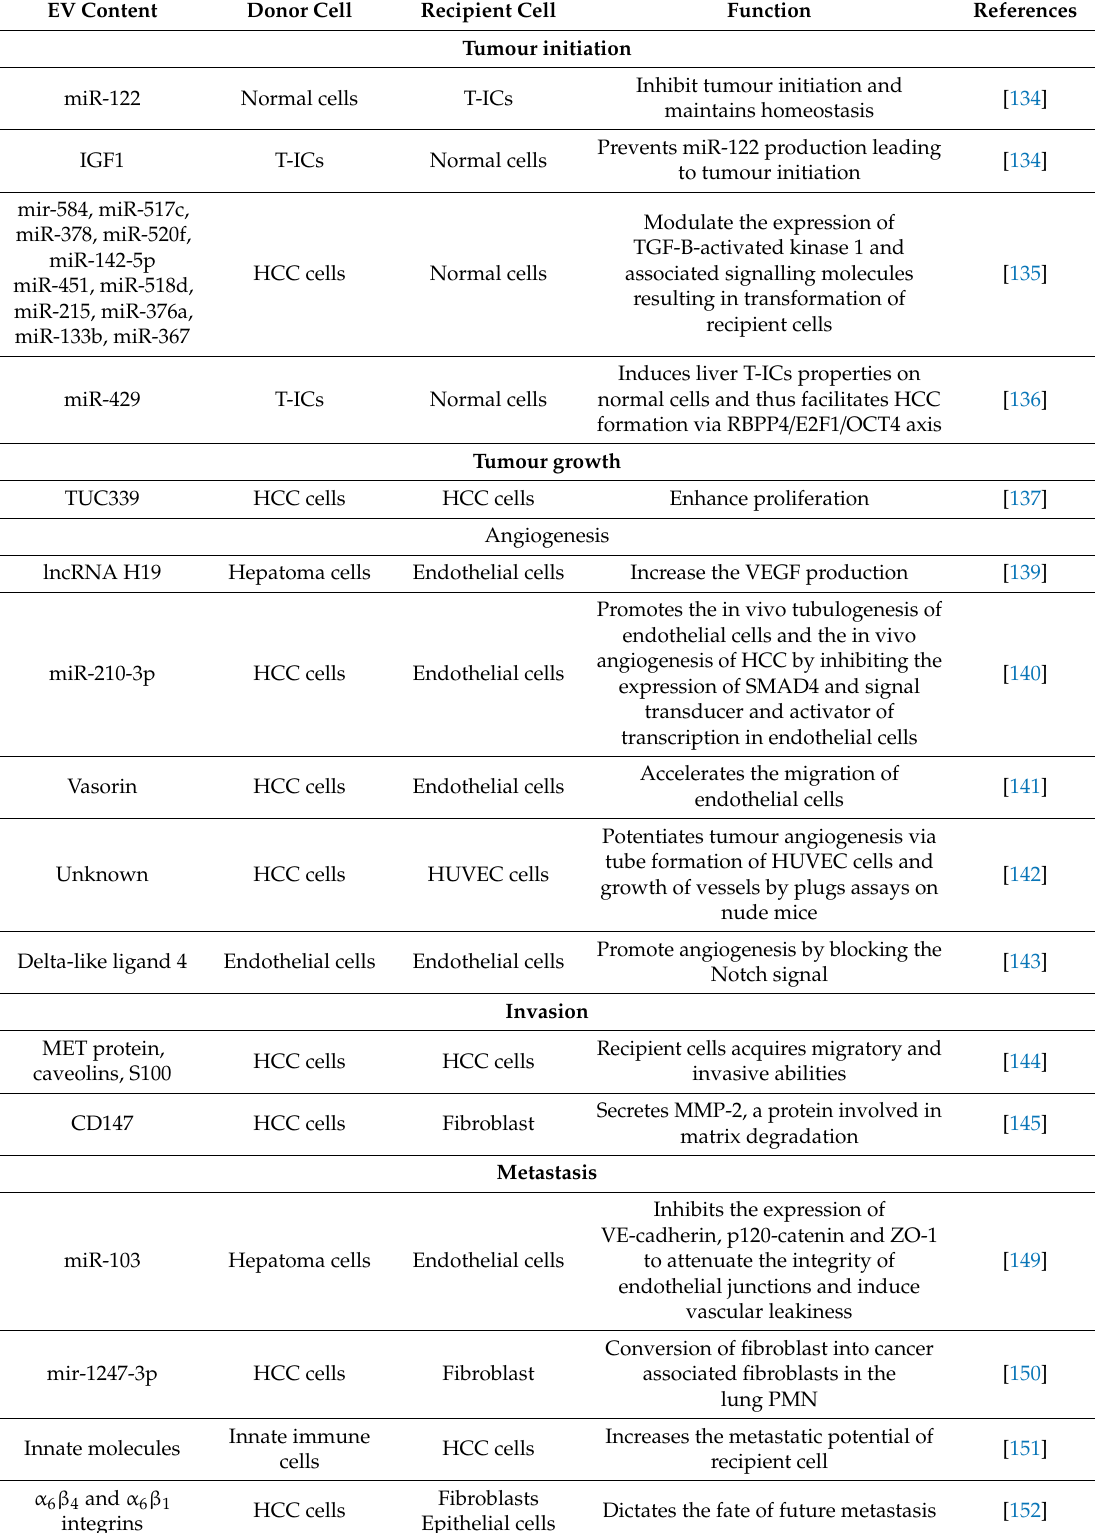
Table 1. Liver parenchyma derived EVs in HCC